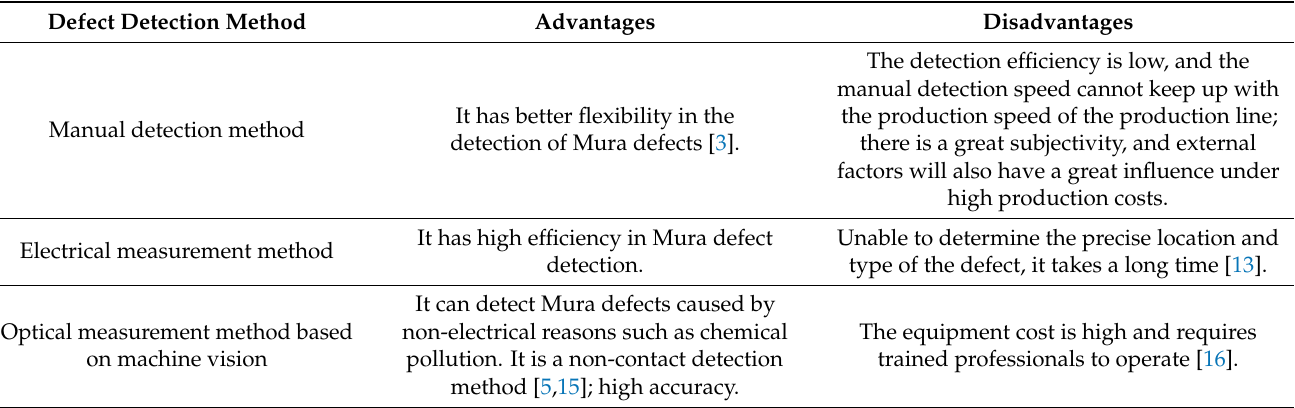
Table 2. Comparison of Mura defect detection